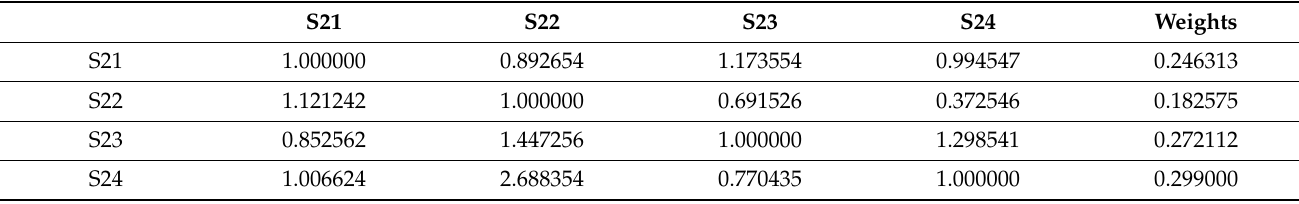
Table 8. The aggregated pairwise comparison matrix at Level 2 for technical.